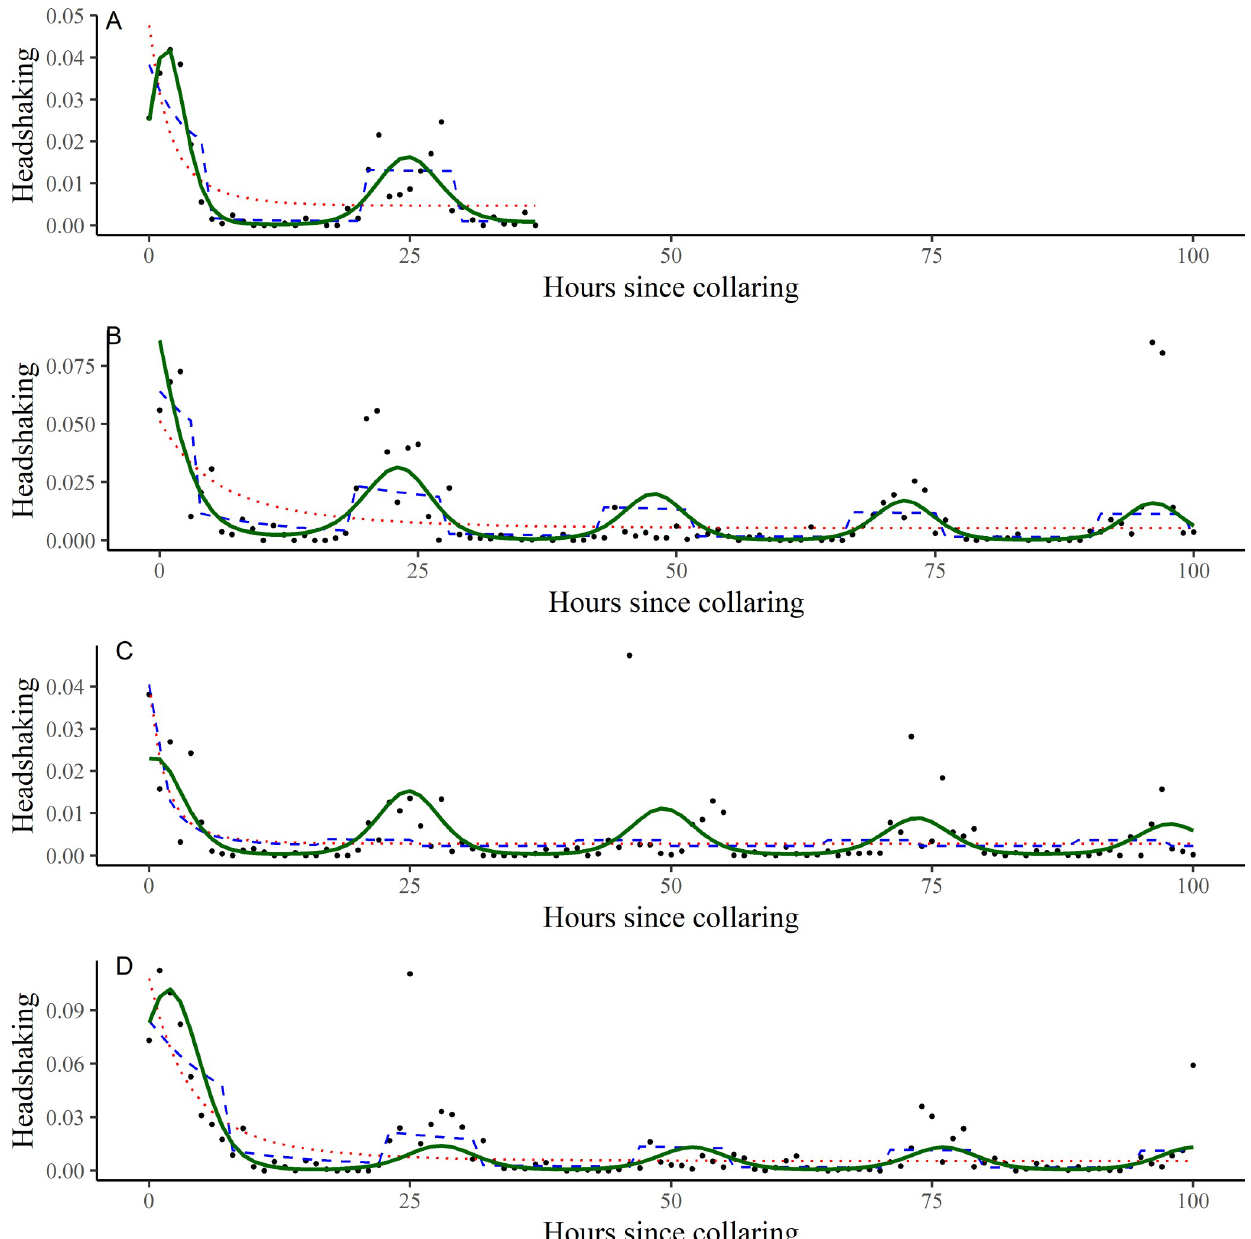
Fig 4. Time-series models predicting headshaking activity in captive scimitar-horned oryx (Oryx dammah). Each figure (A—114839, B—114426, C— 114915, D—114969) represents a different animal (see Table 1). Headshaking was identified from a random forests classification of tri-axial accelerometer (8 Hz) data from Vectronic GPS collars and aggregated to an hourly count. Results show an increase in headshaking activity immediately after GPS collar fitting. Red dotted line—Binomial regression w/ negative exponential decay; Blue dashed line—Binomial regression w/ negative exponential decay + day/ night switch; Green solid line—Binomial regression w/ negative exponential decay + harmonic processes. Headshaking frequency shown as a frequency as black dots. Results truncated to 100 hours for visualization. See S3 Cross Validation for full time-series predictions and estimated parameters from each